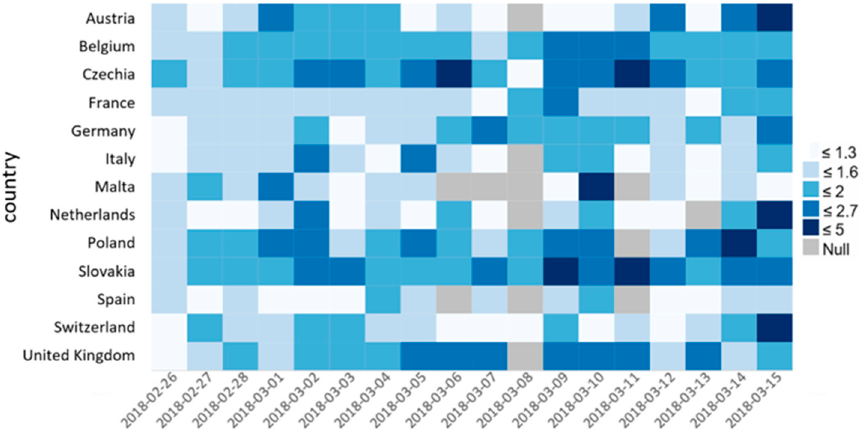
Figure 8. Sentiment class values per day for countries in Cluster 1 and 5 (neutral tweets excluded)— RQ2a and RQ3a.